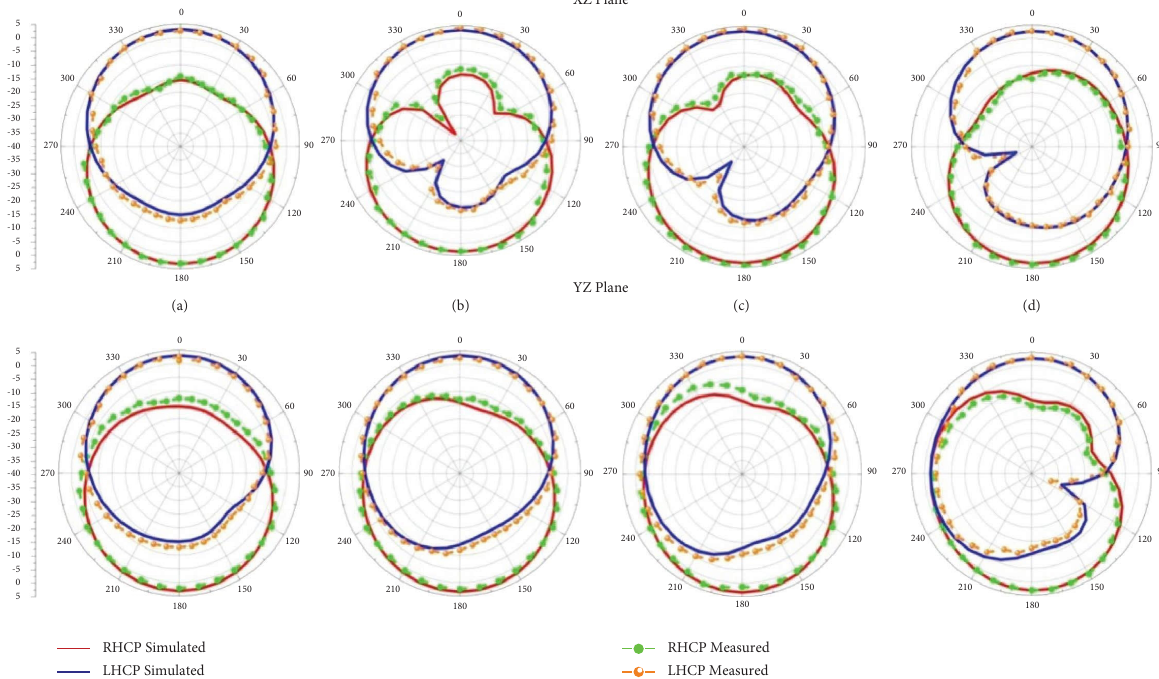
Figure 12: Radiation patterns in the XZ plane and YZ plane for LHCP and RHCP at (a) 4.5 GHz, (b) 5.5 GHz, (c) 5.75GHz, and (d) 6.5